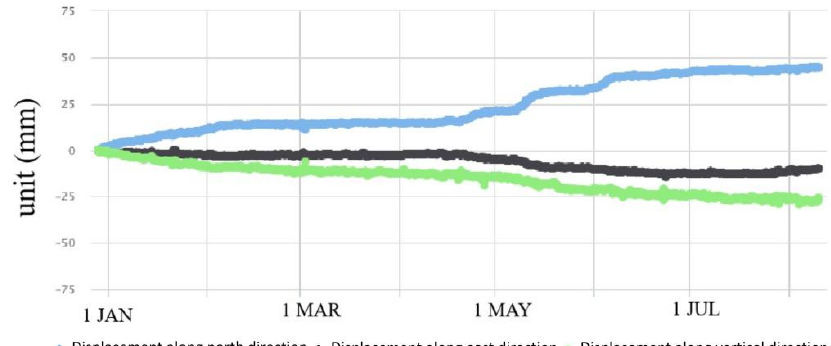
Figure 8. Displacements recorded by GPS 05 in 2016.